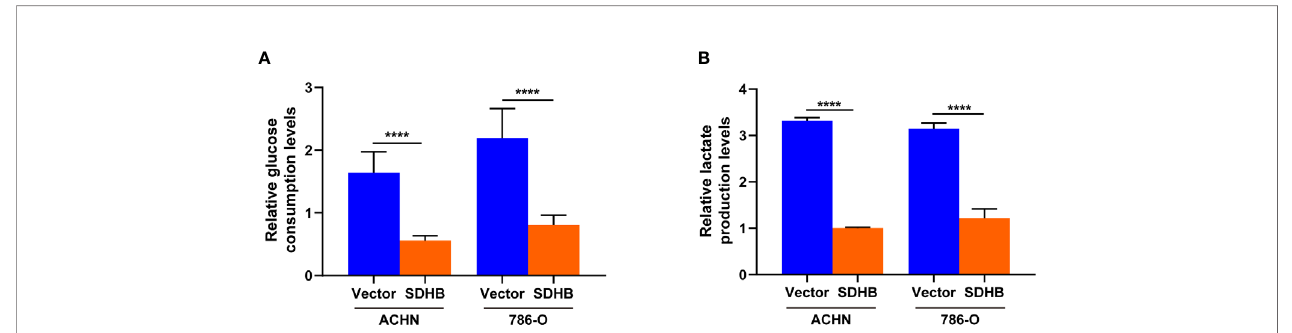
FIGURE 6 | SDHB overexpression inhibits glycolysis in ccRCC cells. (A) Glucose level in SDHB-overexpressing ACHN and 786-O cells. (B) Intracellular lactic acid level in SDHB-overexpressing ACHN and 786-O cells. P value was derived from independent sample two tailed t -test. The data were presented as mean ± SD. **** P < 0.0001. The data are representative of three independent